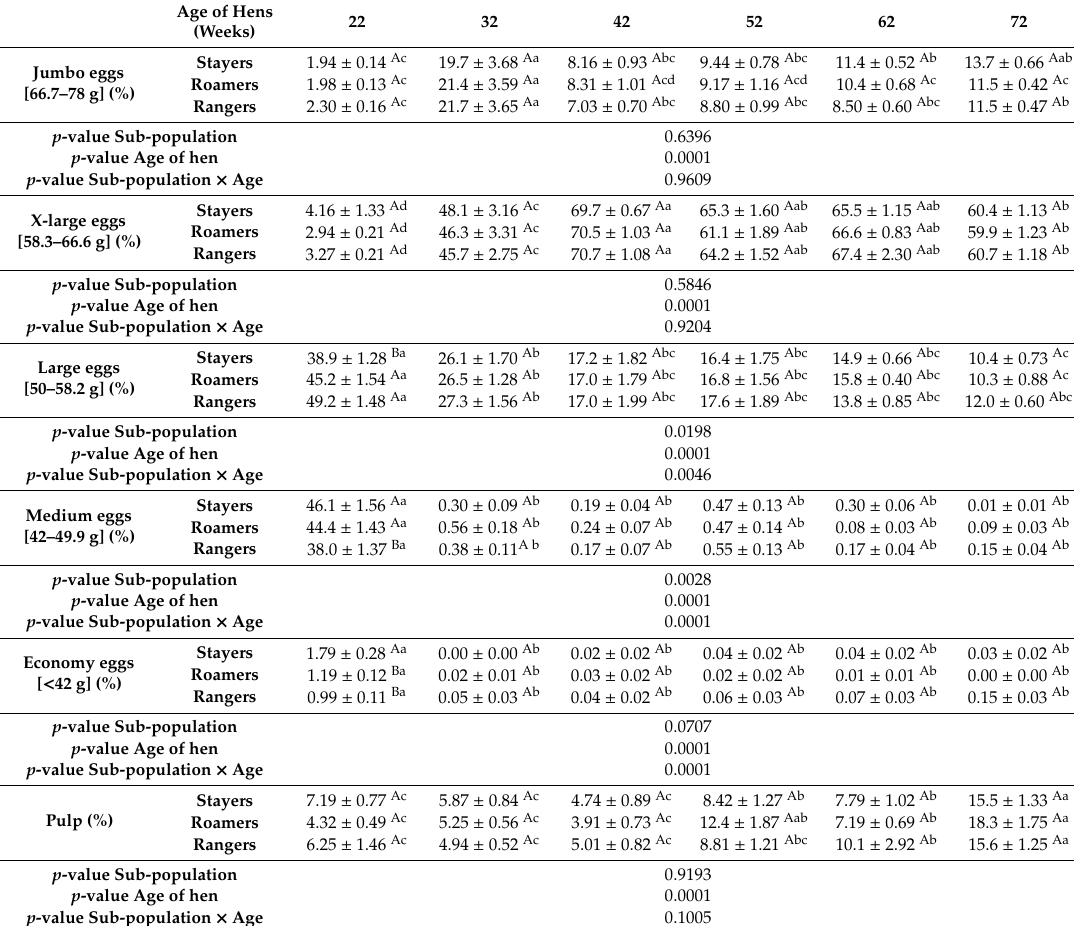
Table 4. The di ff erence between the stayers, roamers and rangers on di ff erent egg grades at 22, 32, 42, 52, 62 and 72 weeks of